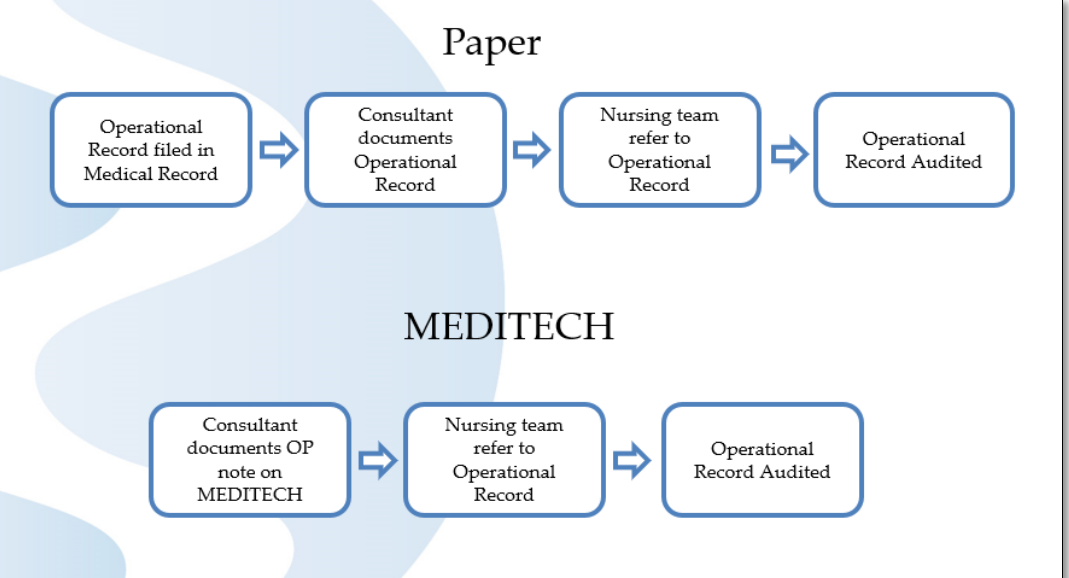
Figure 4. As we think it is process map.